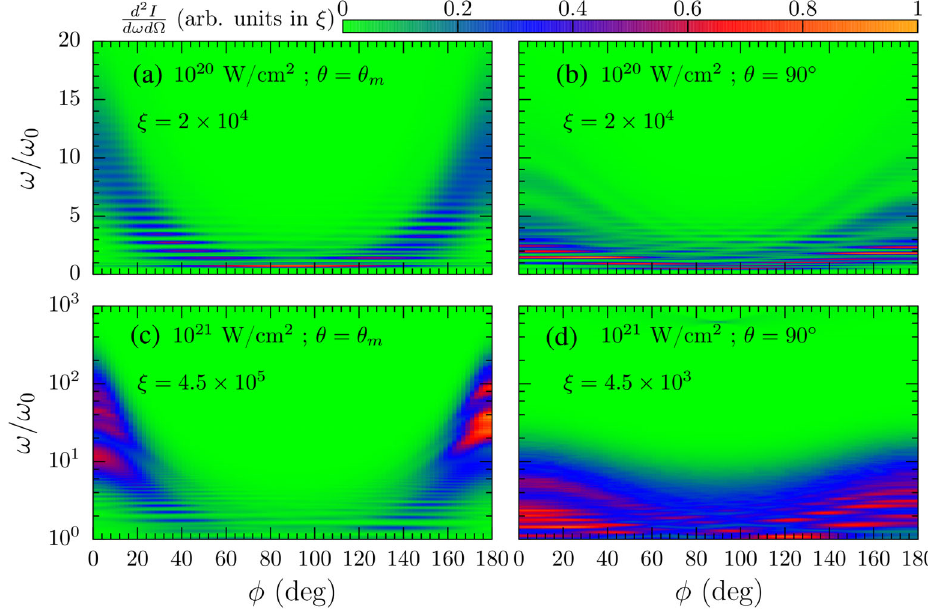
FIG. 4. The angular distribution of different harmonics is presented for 10 20 W = cm 2 and 10 21 W = cm 2 , with ϕ varying from 0 to 180° for a fixed θ ¼ θ m and θ ¼ 90 °. The respective scaling factors are also shown in the plots.